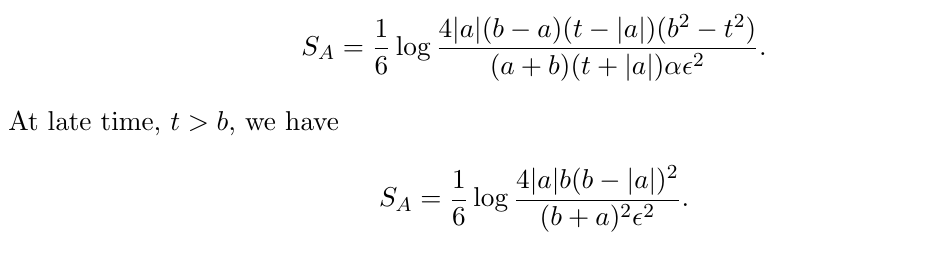
Figure 7 . The plots of the entanglement entropy growth S A (cid:0) S (0) describes the time evolution when we take ( a; b ) = (15 ; 20). The middle one is the time evolution for ( a; b ) = (0 : 1 ; 20). The right one is the plot for various (cid:24) when we (cid:12)x l = 2 and t =